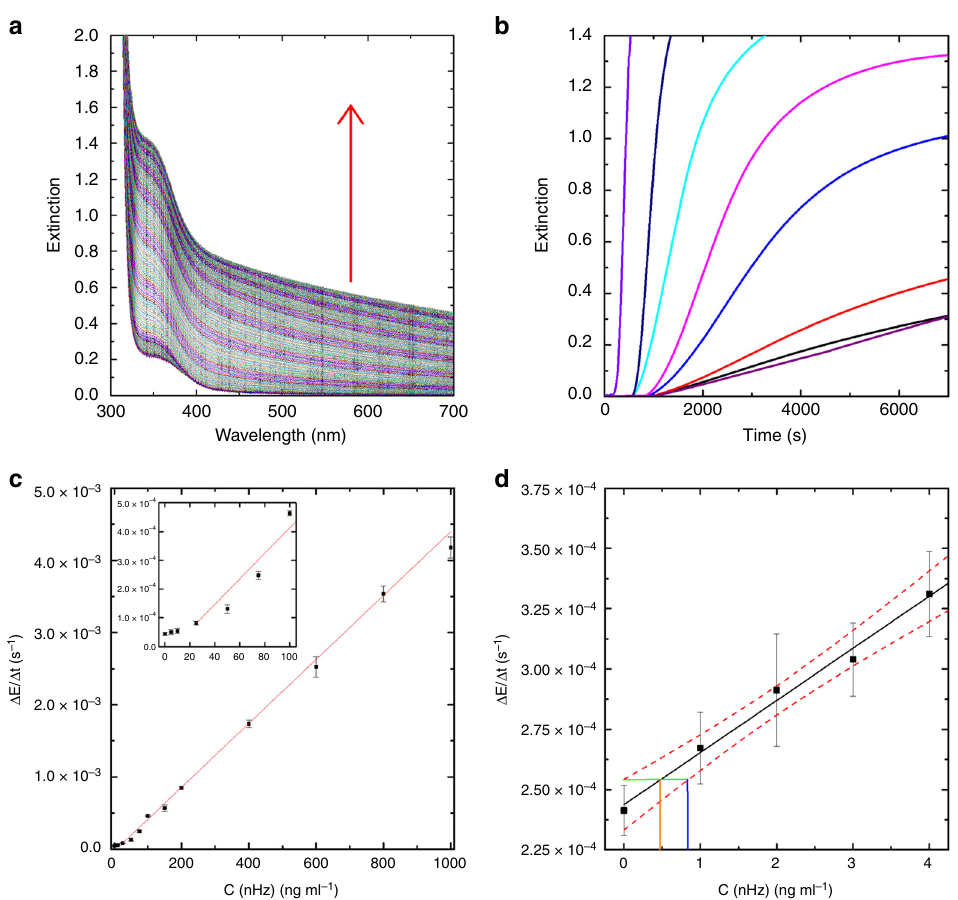
Fig. 2 Precipitation polymerizations catalyzed by nHz quanti fi ed by extinction measurements. a Time-dependent UV – vis measurements of a NIPAAm polymerization catalyzed by 25 ng mL − 1 nHz. The spectra were recorded every 30 s. b Time-dependent extinction measurements at 600 nm of NIPAAm polymerization catalyzed by 10 ng mL − 1 (black), 25 ng mL − 1 (red), 50 ng mL − 1 (blue), 100 ng mL − 1 (pink), 150 ng mL − 1 (cyan), 400ng ml − 1 (navy blue), and 1000 ng ml − 1 nHz (violet). A blank reaction without nHz is also observed (purple). c Dose-response curve for nHz at 600 nm. (Average of n = 5 and SD; the red line represents the linear fi t to the data between 25 ng mL − 1 and 1000 ng mL − 1 ) d Dose-response curve for low concentrations of nHz at 380 nm (Average of n = 6 and SD; the black line represents the linear fi t to the data, the red dotted lines indicate the 95% con fi dence interval, the orange vertical line indicates the decision limit and the blue vertical line indicates the detection